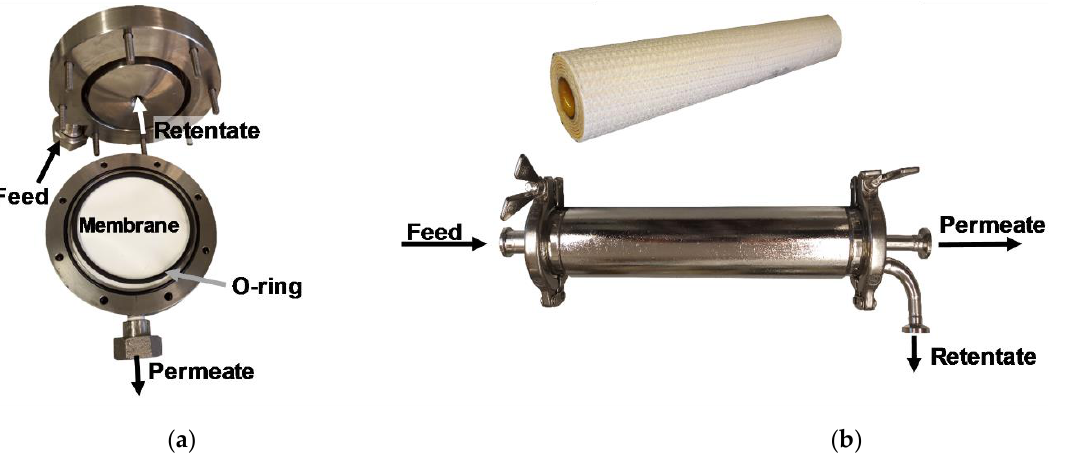
Figure 2. Visualization of modules used. ( a ) flat-sheet module; ( b ) spiral wound membrane and housing (1812 ″ ).